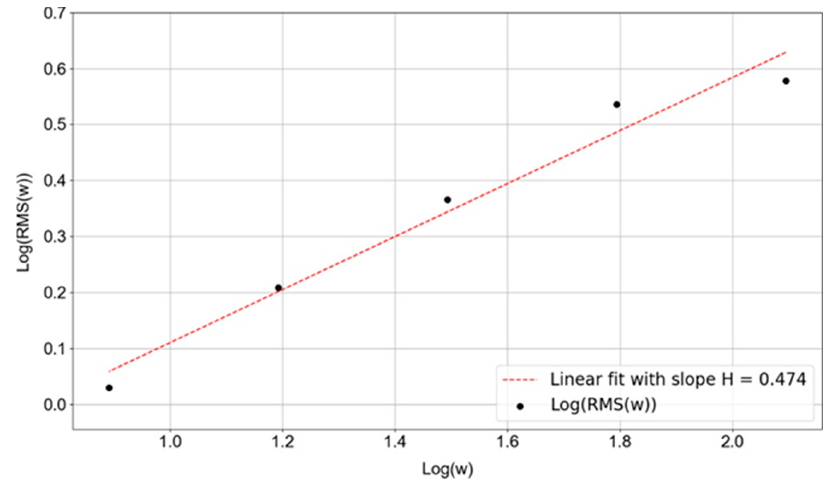
Figure 5. Determination of the slope H .